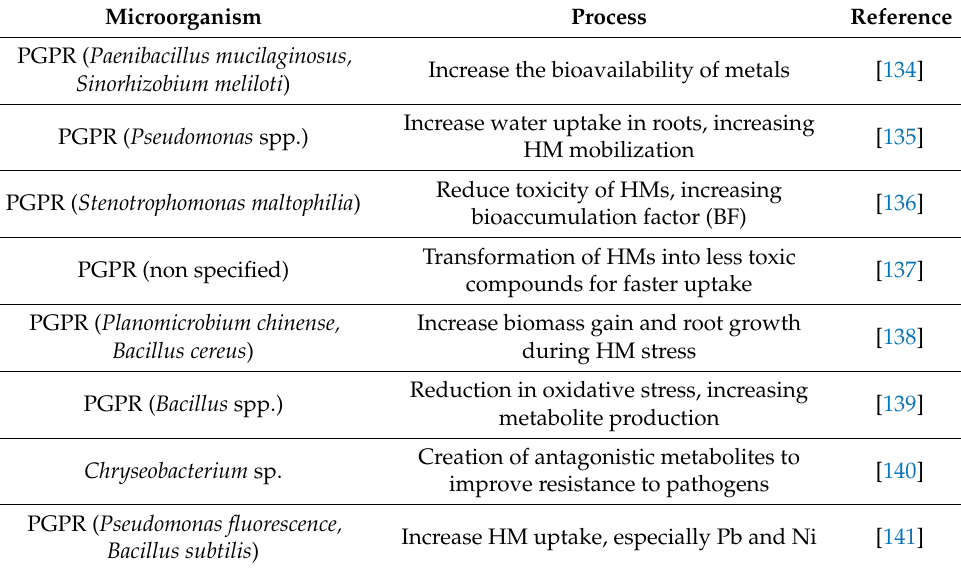
Table 2. Different processes in the root-microorganism association during phytoremediation of HMs in water.